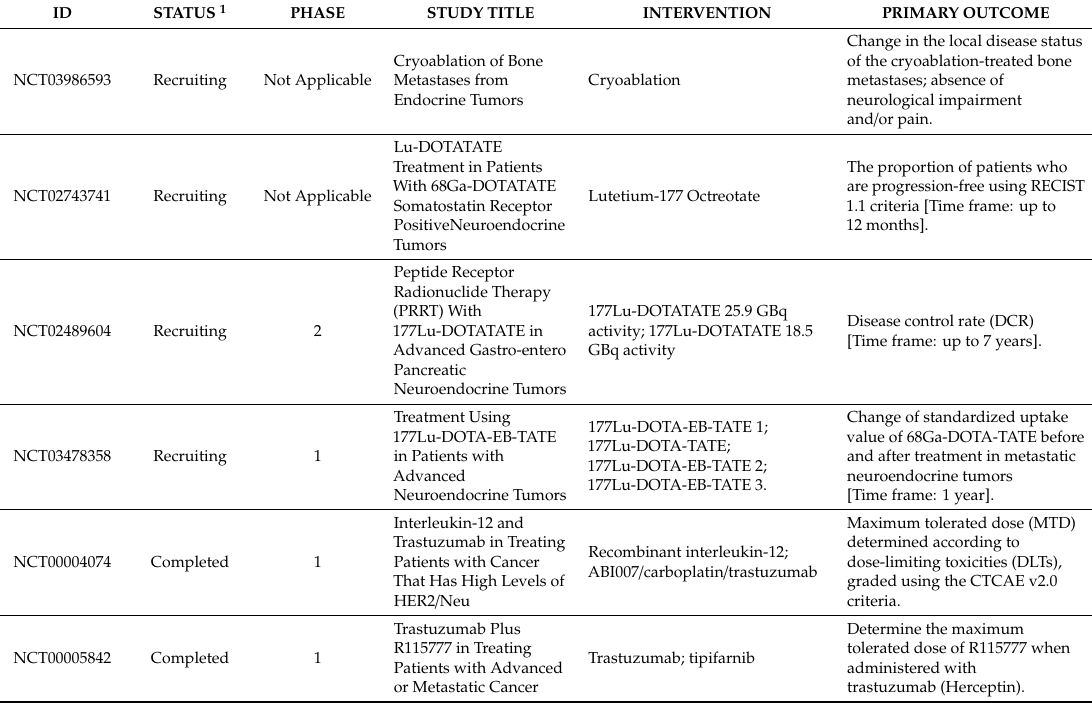
Table 1. Ongoing clinical trials for the treatment of bone metastases in neuroendocrine